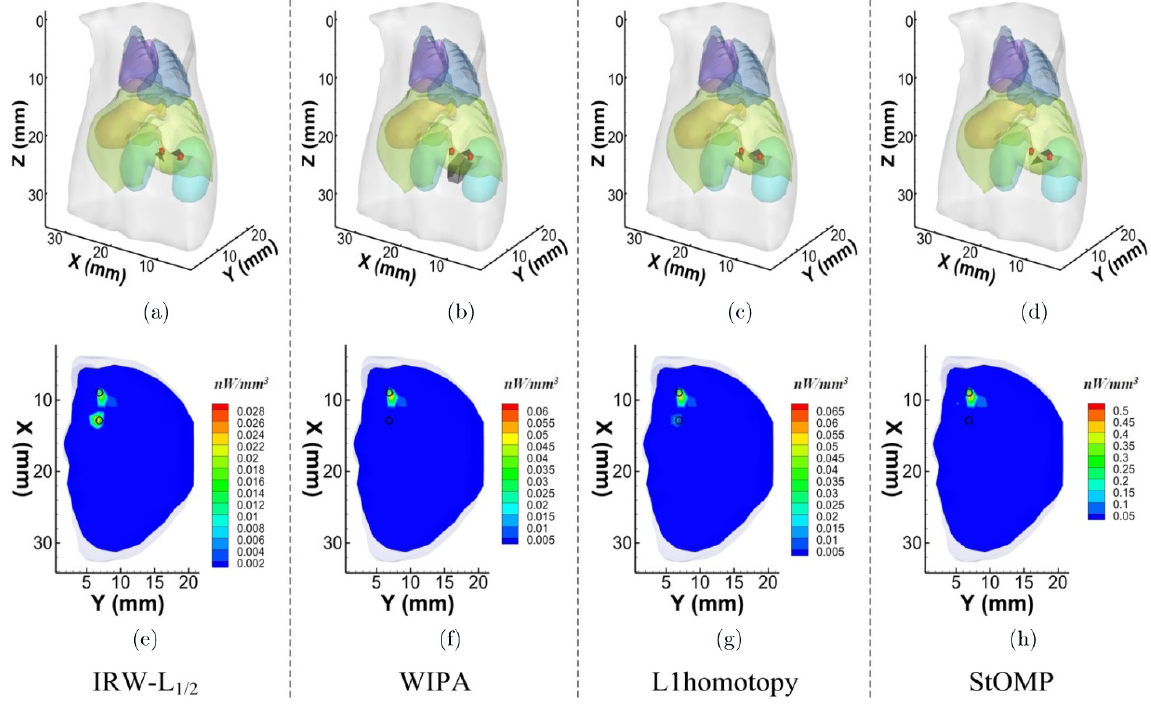
Fig. 7. Reconstruction results by the four algorithms in double-source simulation. The top row shows the 3D views of results by IRW-L 1 = 2 , WIPA, L1 homotopy and StOMP, respectively. The bottom row shows the corresponding transverse views at z ¼ 20 mm, where the actual source centers